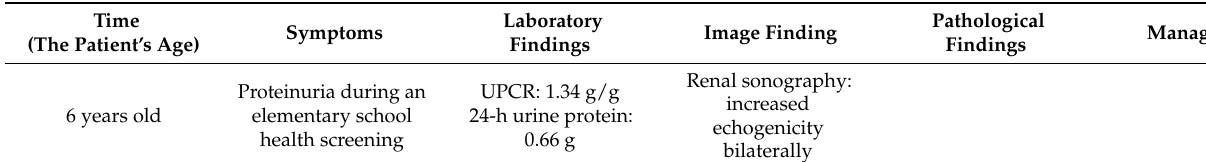
Table 1. Brief summary of this patient’s